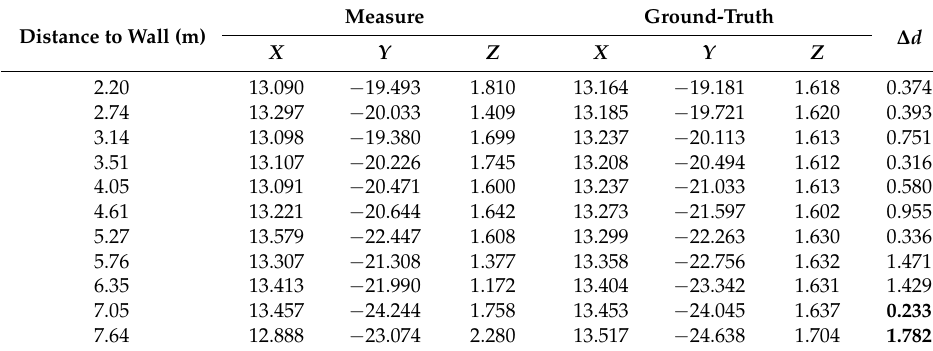
Table 7. Analysis of images along a line.